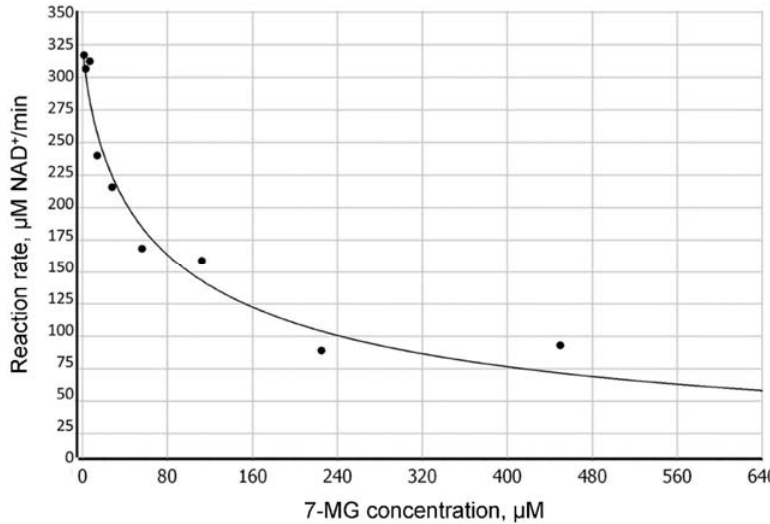
Figure 2. Dependence of the PARP-1-catalyzed reaction rate on the concentration of 7-MG inhibitor determined by fluorescence anisotropy (100 μ M NAD + concentration).